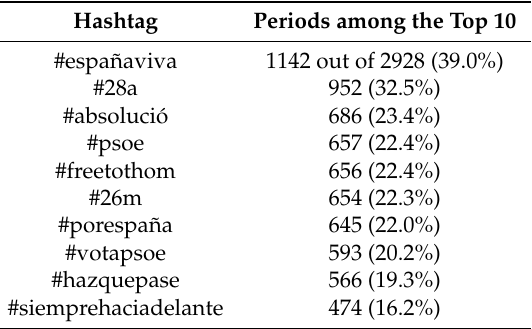
Table 2. Hashtags that appear in the largest number of hourly extraction